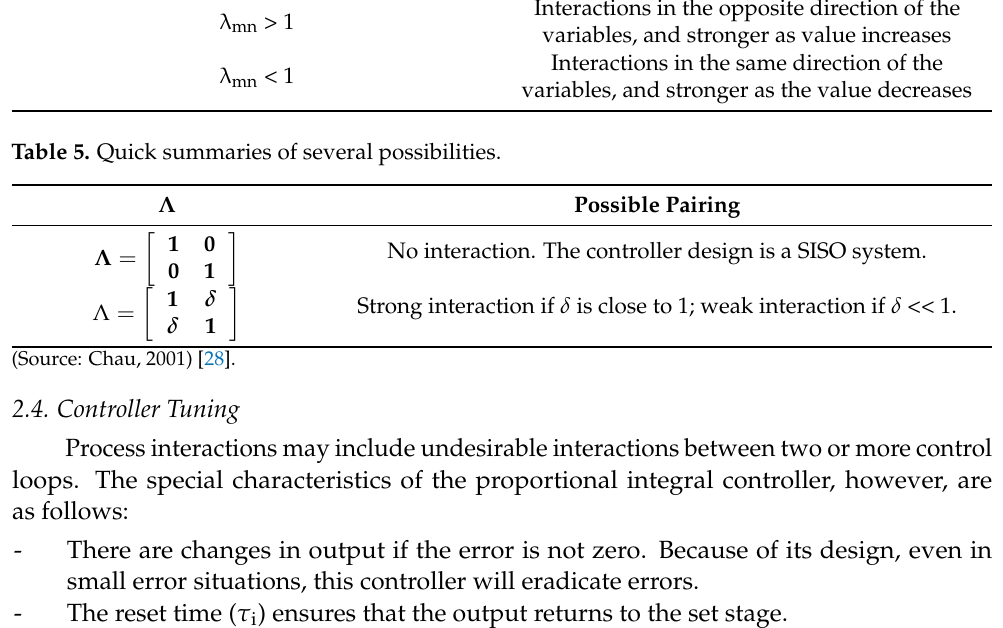
Strong interactions Interactions in the opposite direction of the variables, and stronger as value increases Interactions in the same direction of the variables, and stronger as the value decreases